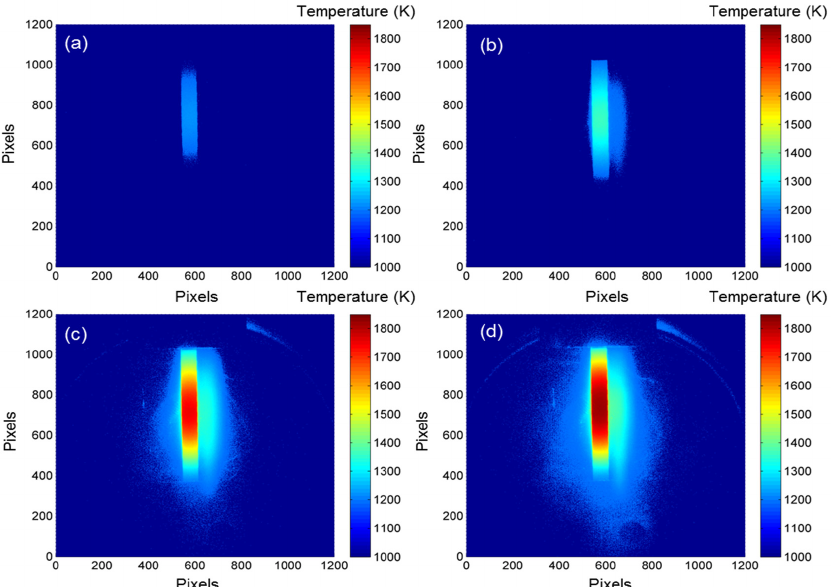
Figure 7. Typical temperature fields obtained by established model at different temperatures: ( a ) 1213 K, ( b ) 1415 K, ( c ) 1753 K and ( d ) 1835 K.